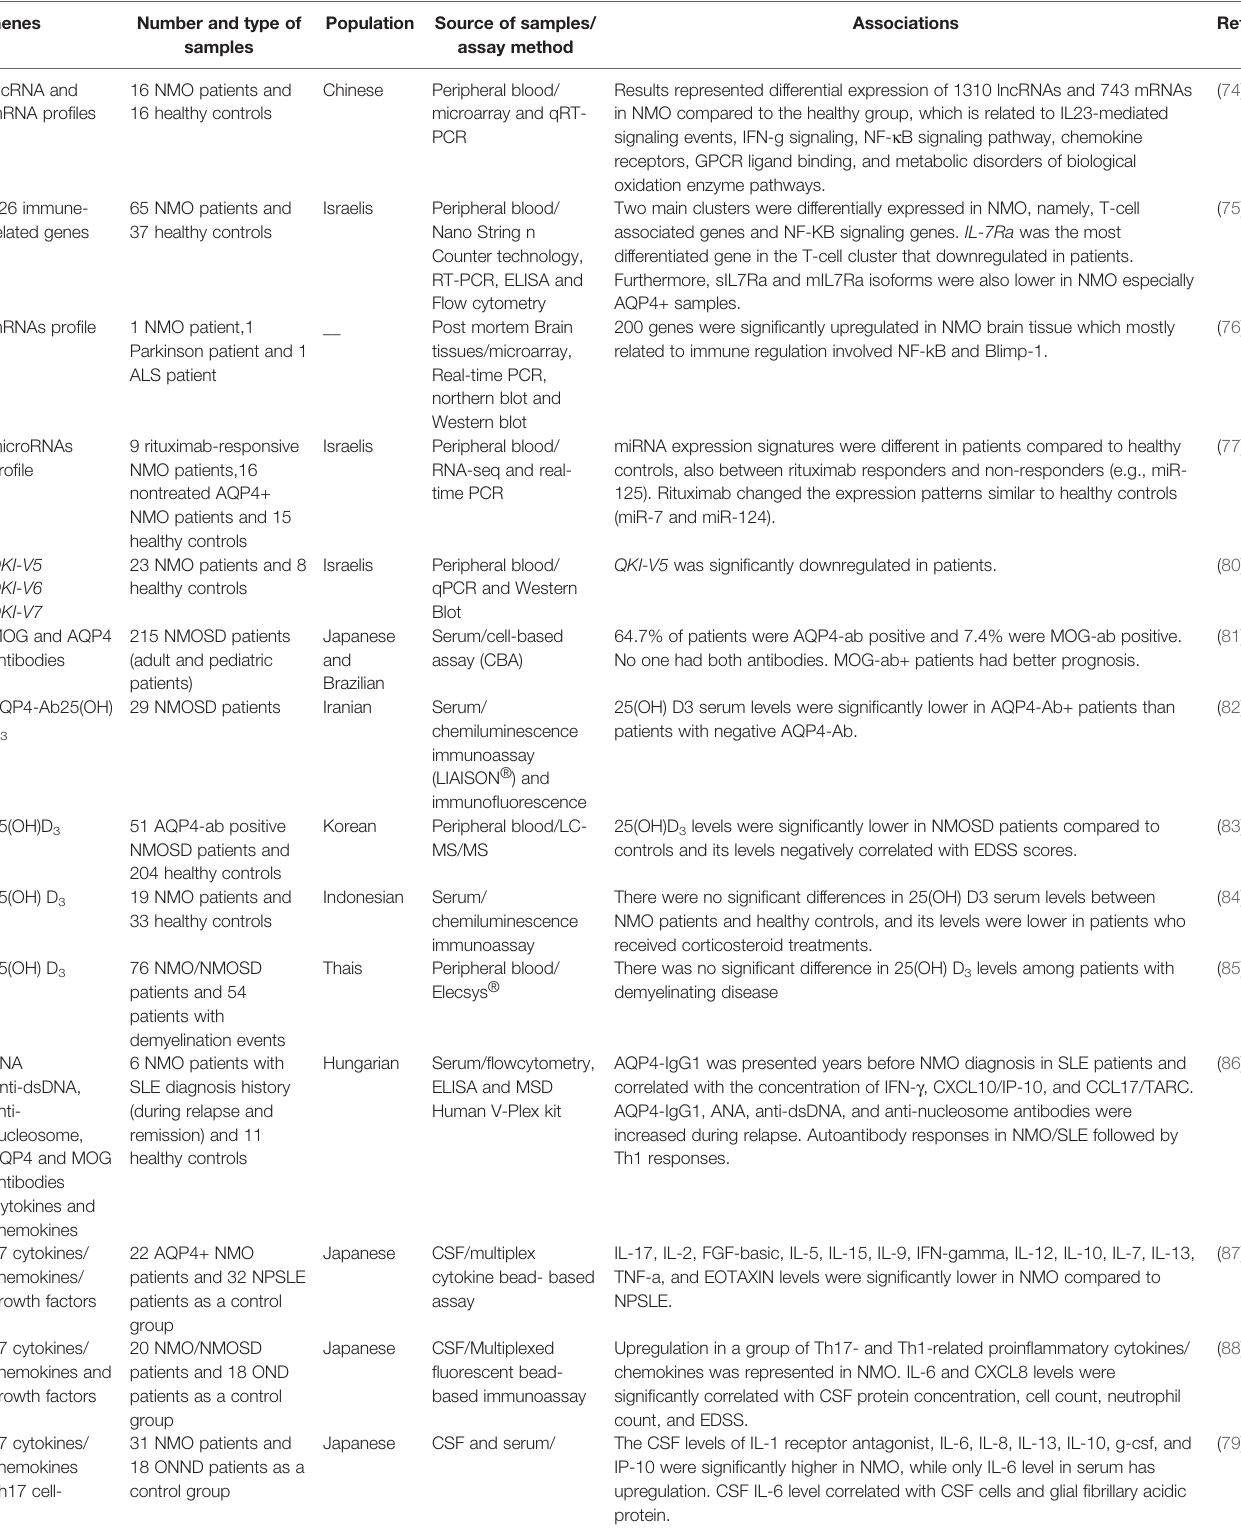
TABLE 4 | Expression studies in neuromyelitis optica (NPSLE, neuropsychiatric systemic lupus erythematosus; ONND, other non-in fl ammatory neurological disorders; OND, other neurological